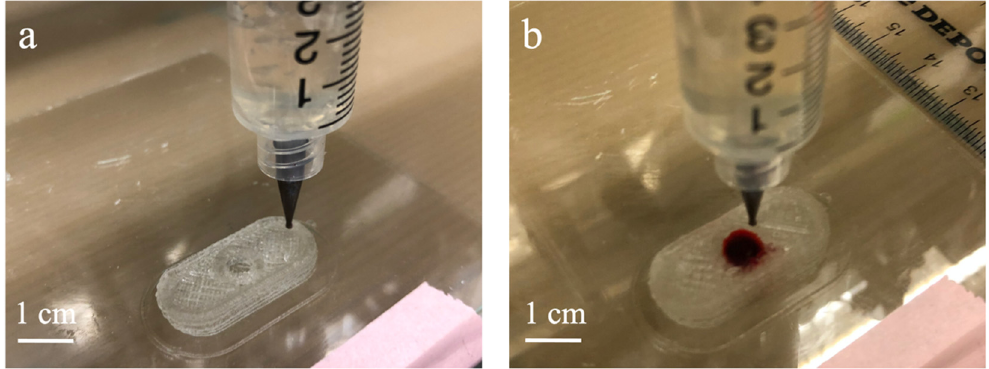
Figure 1. Printing process: ( a ) 7th layer; ( b ) colorant injected after the 7th layer.